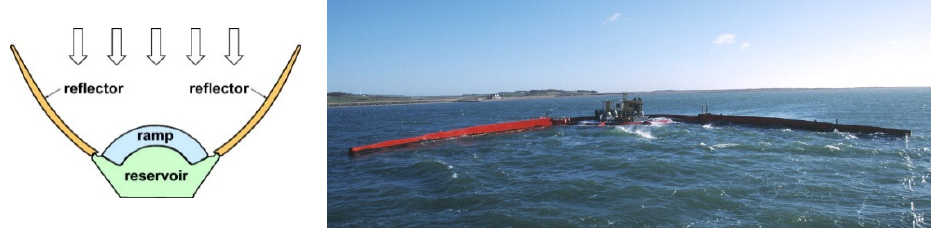
Figure 29. View ( left ) [97] and schematic plan view ( right ) of Tapchan (Reproduced with permission 5139270373963 from [32], Elsevier, 2010). It is also possible to realize an OD for an offshore application. As an example, the Wave Dragon was a floating slack moored WEC, developed by the Danish company “Wave Dragon Aps”. In March 2003 a 20 kW prototype (scale 1:4.5) was installed and tested in the Nissum Bredning fjord until January 2005 [98]. In detail, Wave Dragon is composed of a floating water reserve, refilled with sea waves using two reflectors (see Figure 30) [32,99], and a ramp to convert the kinetic energy into potential energy through the increasing of water level [99]. This kind of energy can be used by Kaplan turbines to run permanent magnets rotary generators. To work properly, the system should be fixed to the seabed by moorings and faced to the wave direction [70].